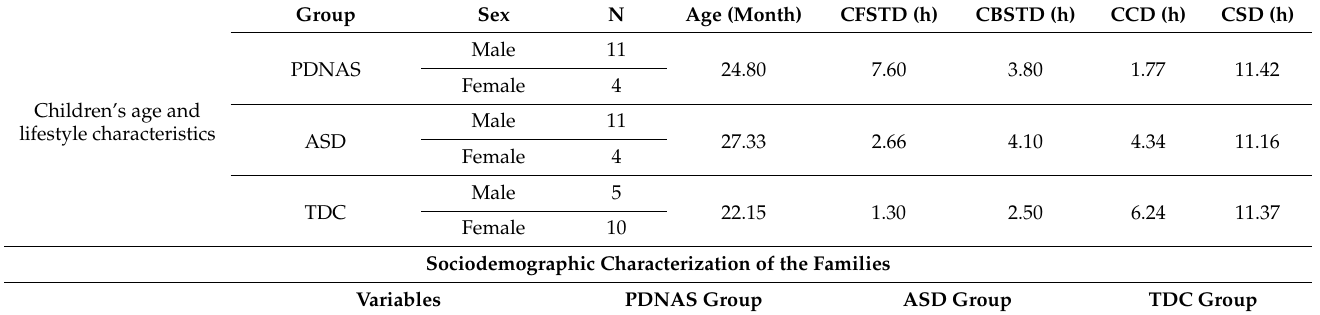
Table 2. Sociodemographic characterization of the families and